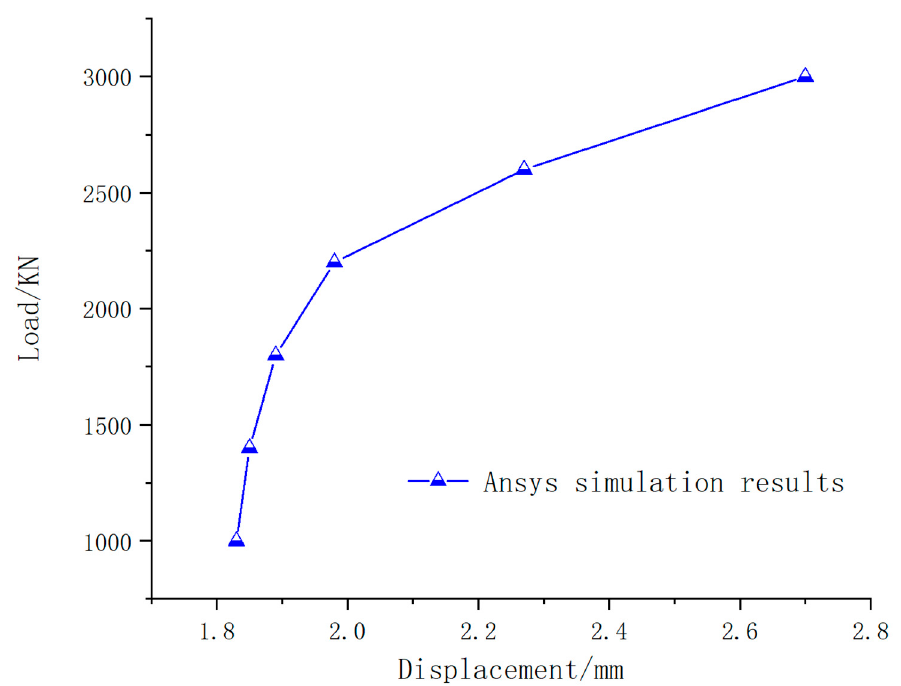
Figure 14. Load–maximum lateral displacement relationship diagram.